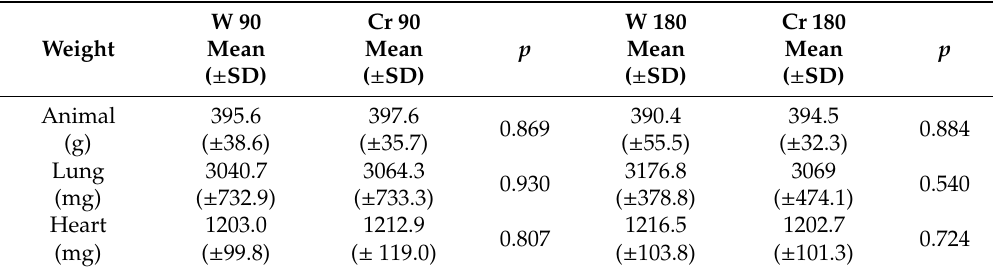
Table 1. Lung and heart